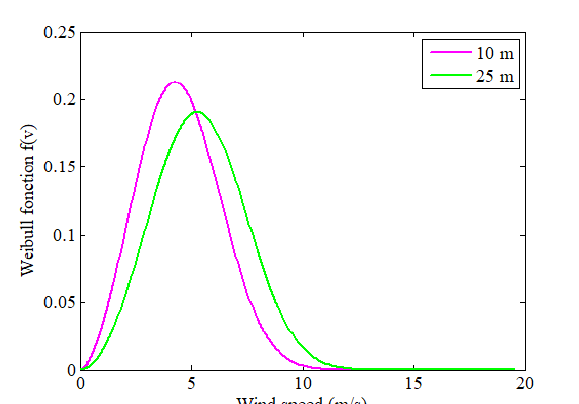
Figure 5. Annual frequency distribution of wind speeds from Weibull model (1981-